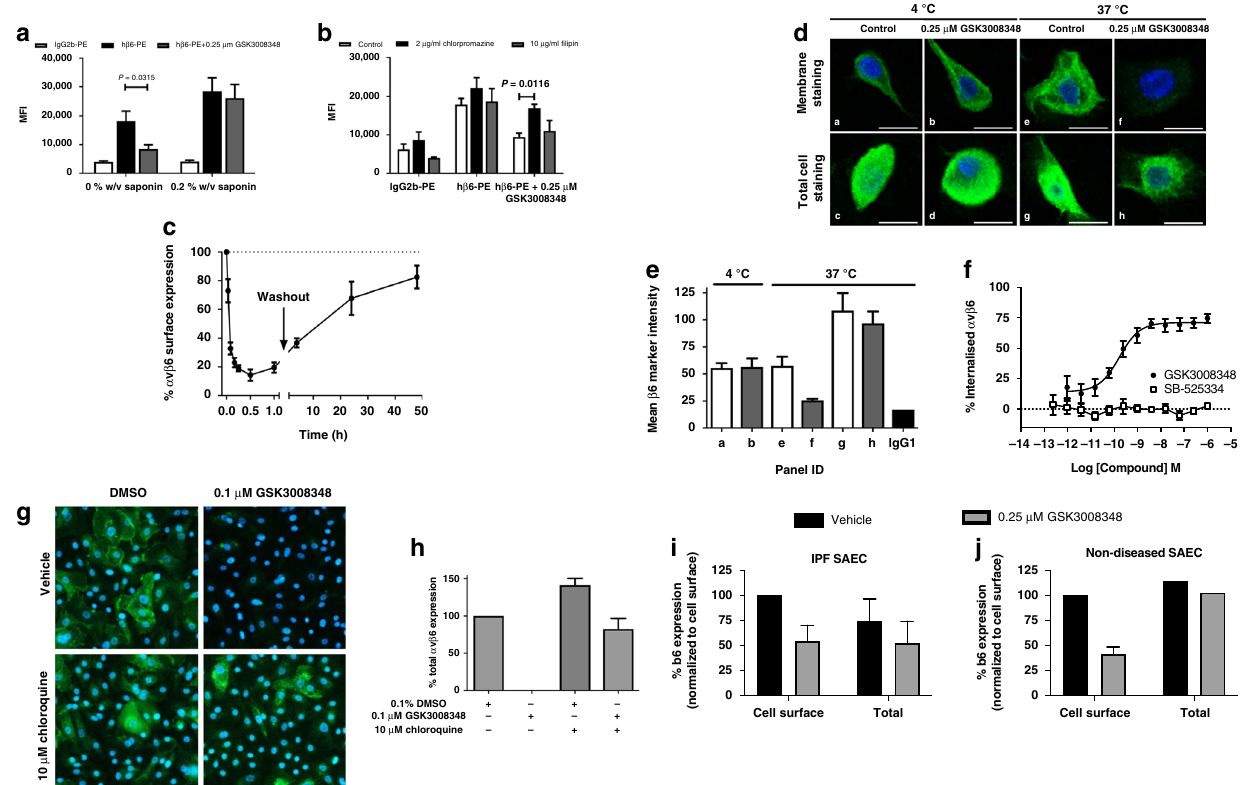
Fig. 3 GSK3008348-induced internalization and degradation of the α v β 6 integrin. Flow cytometry using NHBE cells showing a ligand-induced α v β 6 internalization triggered by GSK3008348, b the effect of chlorpromazine and fi lipin on ligand-induced α v β 6 internalization (mean ± SEM; n = 4 – 6; ANOVA with Tukey ’ s post test comparisons versus h β 6-PE or control), and c the kinetics of GSK3008348-induced α v β 6 internalization and return post-washout determined via fl ow cytometry in (mean ± SEM; n = 4). d Localization of α v β 6 integrin in NHBE cells post-GSK3008348 addition ( β 6 integrin (green) and nucleus (blue)) imaged by confocal microscopy to produce a 3D cell z-stack. Representative single cells (×50 magni fi cation; scale bar = 50 µ m) from four optical sections captured per condition with e the mean β 6 marker intensity for optical sections shown (mean ± SEM from single experiment). f Flow cytometric analysis of the concentration-dependency of GSK3008348-induced α v β 6 internalization (mean ± SEM; n = 4). g The effect of the lysosomal degradation inhibitor chloroquine on GSK3008348-induced α v β 6 degradation in NHBE cells measured by high-content screening with example images and h quanti fi cation of α v β 6 via image analysis (×10 objective with average of fi ve optical fi elds) (mean ± SEM; n = 5). Ligand-induced α v β 6 internalization in SAECs from i IPF ( n = 2) and j non-diseased patients ( n = 2) at 1 h. Source data are provided as a Source Data fi